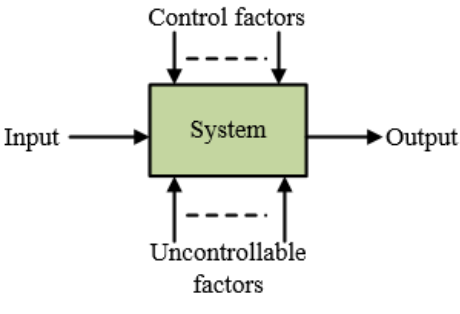
Figure 5. A system undergoing an experiment. Figure 5 . A system undergoing an experiment. Table 1 . A typical Taguchi orthogonal array (OA). Table 1. A typical Taguchi orthogonal array